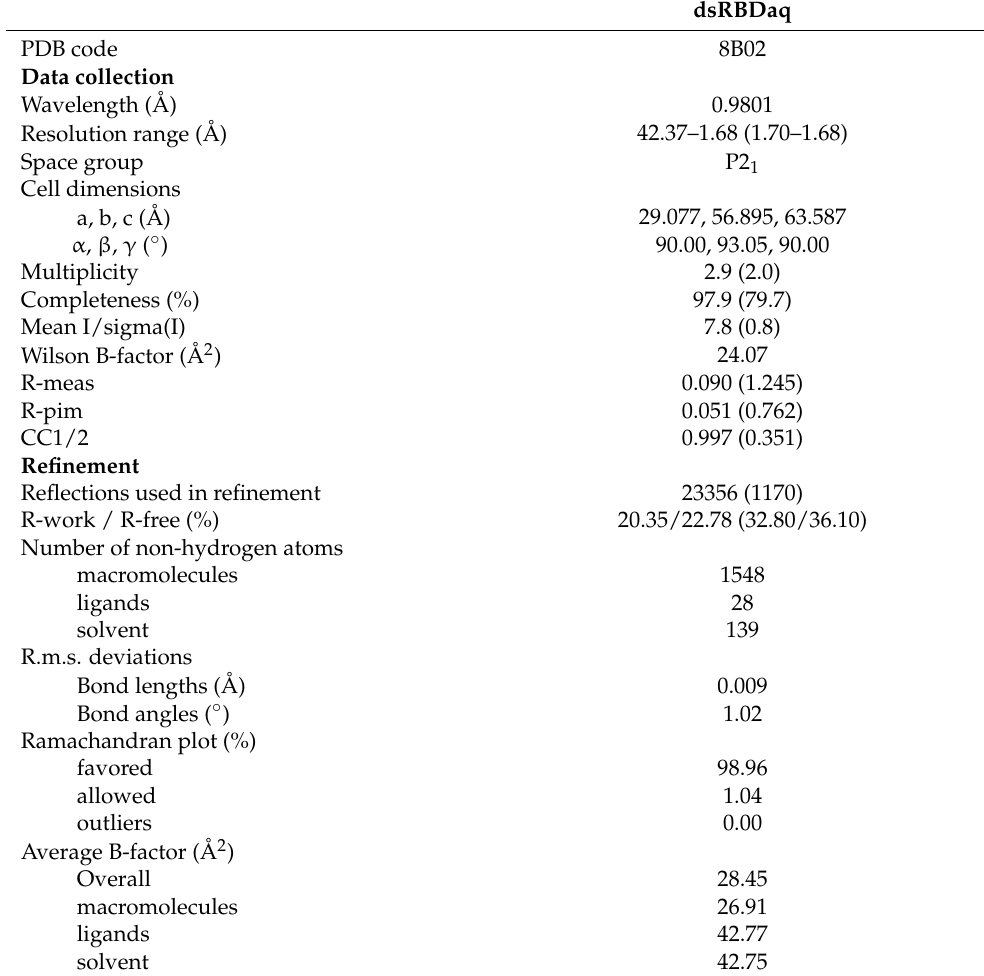
Table 2. Data collection and refinement statistics of the dsRBD of A. queenslandica